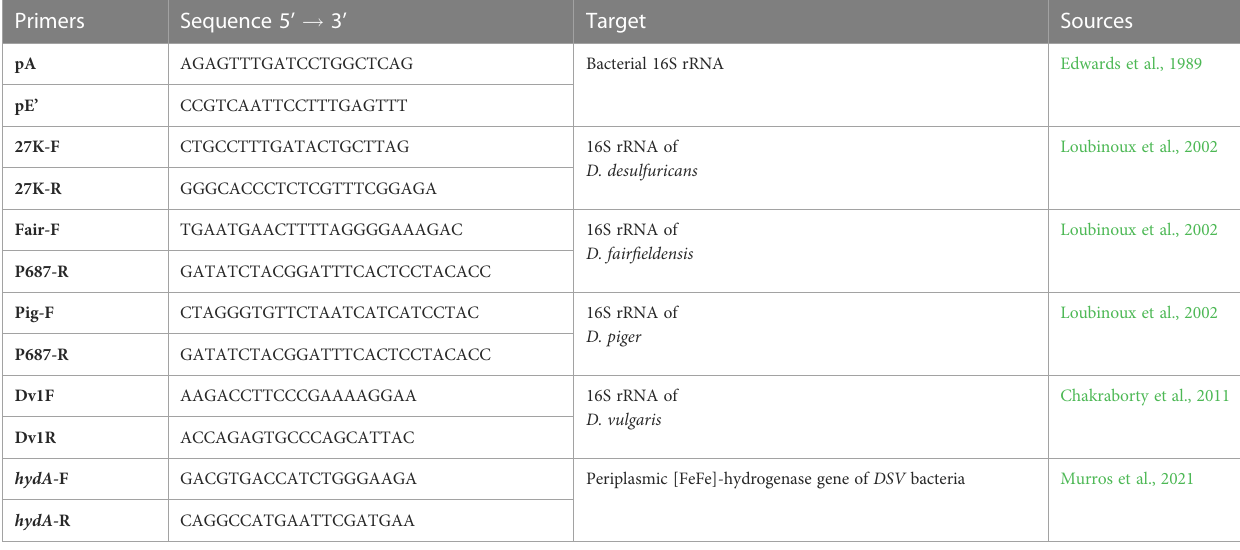
TABLE 1 Primers used in the